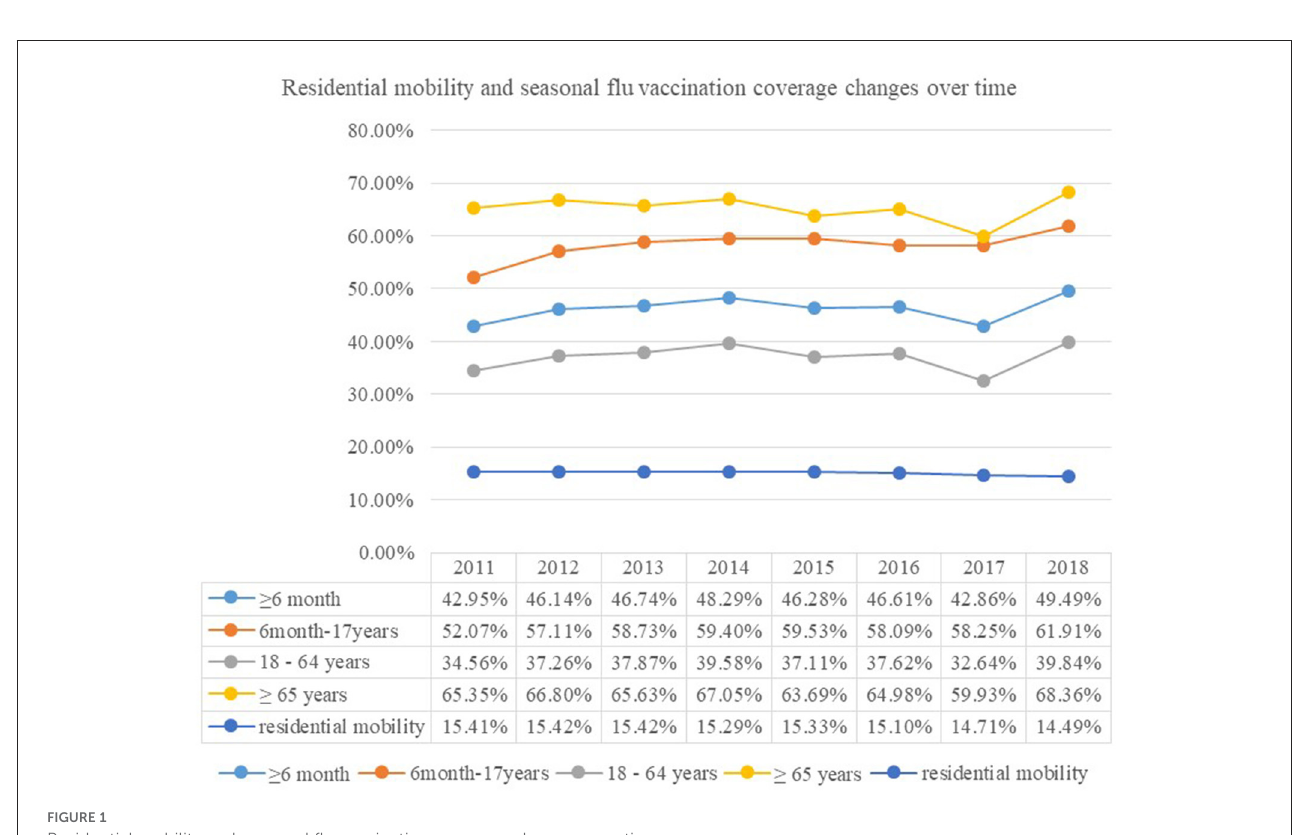
percentage of people receiving flu vaccination in the corresponding flu season. However, further subgroup analyzes indicated that the results differ across years and age groups. For example, residential mobility did not predict seasonal flu vaccination coverage of the population over 65 years in the years